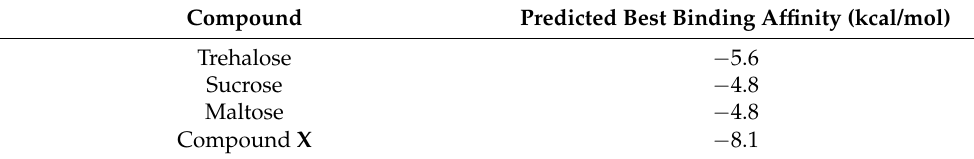
Table 1. Docking energies of disaccharides and Compound X against the CDR3 of the mAb1 heavy chain. Binding of Compound X to mAb1 is more energetically favourable towards the calculated aggregation- prone region compared to commonly used disaccharide excipients. Hence, the Com- pound X can act as a selective aggregation breaker on mAb1 CDR3.